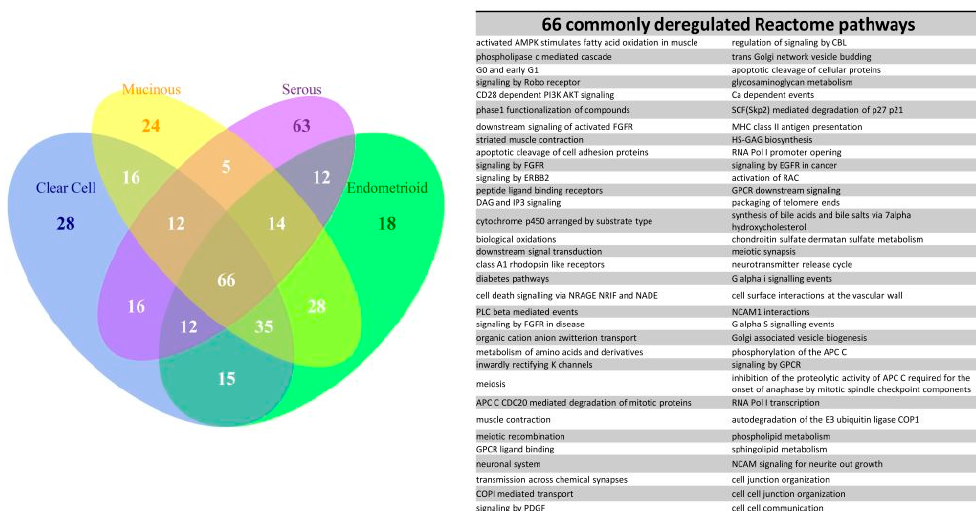
Figure 5. Venn diagram of the top 200 significantly deregulated Reactome pathways for the four subtypes. The results of set analysis for the four EOC subtypes with the top 200 significantly deregulated Reactome pathways ranked by the p values were displayed on the Venn diagram to show the gene set numbers of all possible logical relations among the four subtype groups. The 66 common deregulated Reactome pathways among the four subtype groups were listed on the right side of the diagram.